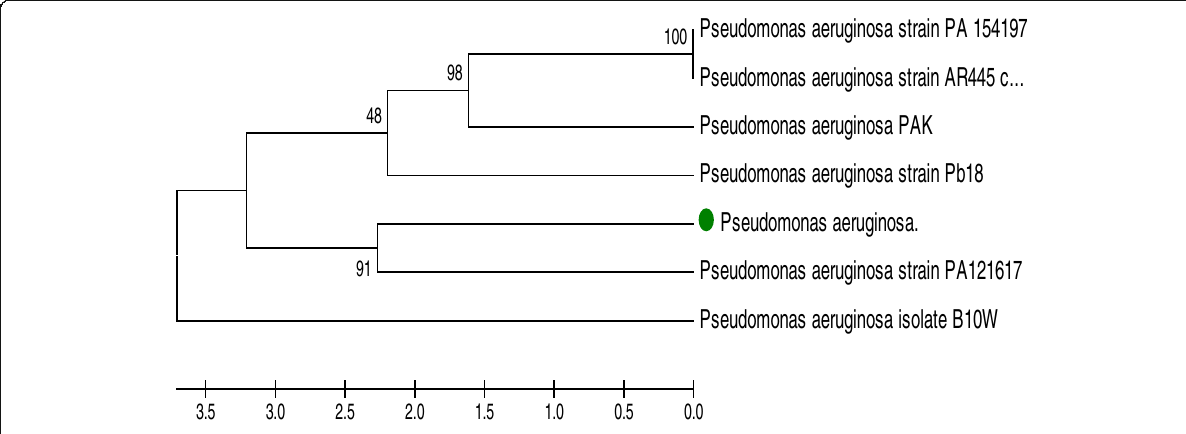
Fig. 3. The phylogenetic relationships between the isolated Pseudomonas aeruginosa and the most closely related bacterial strains presented in the GenBank